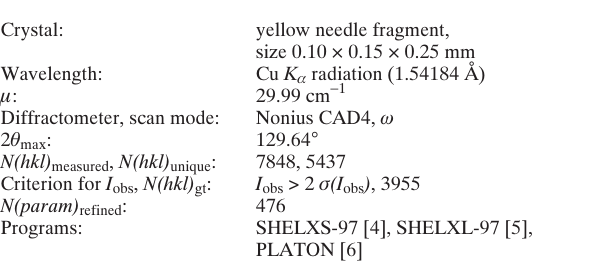
Table 1. Data collection and handling.